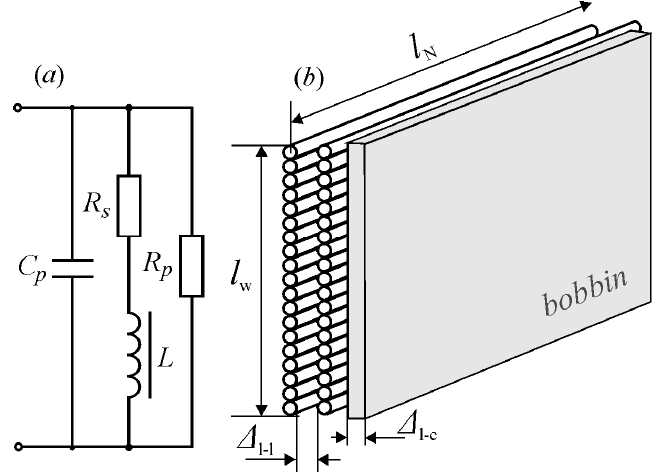
Figure 3. ( a ) Equivalent circuit with lumped parameters of winding and ( b ) graphical presentation of two-layers standard wound inductor.